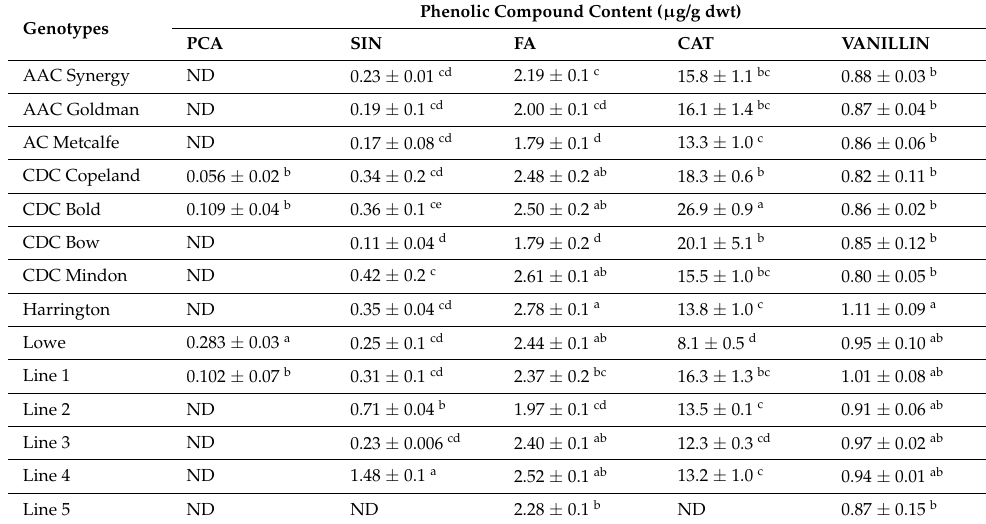
Table 3. Free phenolic compound content ( µ g/g dwt) in barley grain samples.